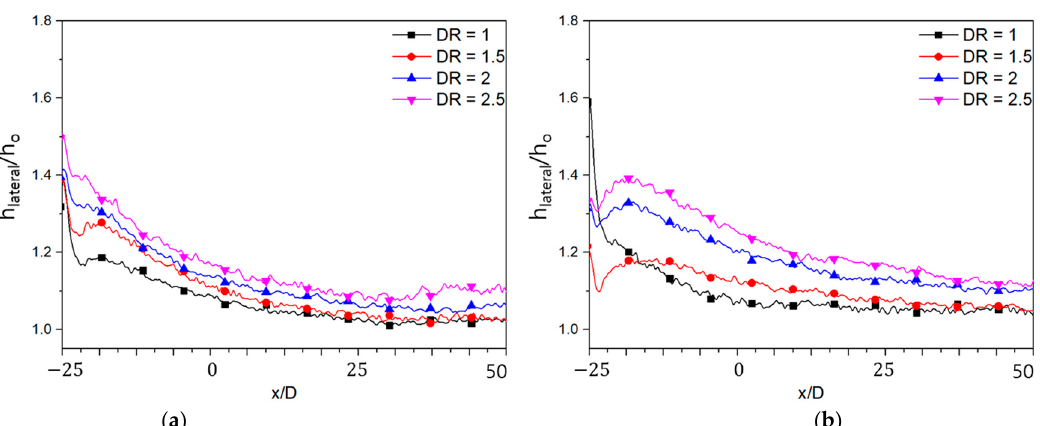
Figure 17. h lateral /h o for different density ratios: ( a ) M = 1.0; and ( b ) M = 2.0.